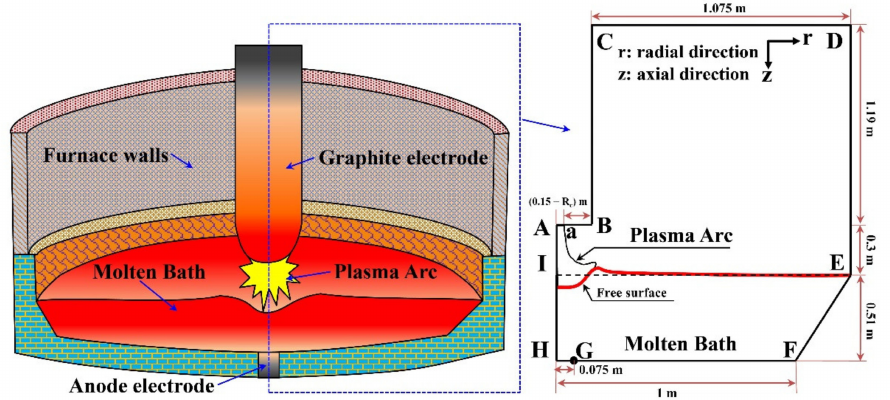
Figure 1. Schematic illustration of calculation